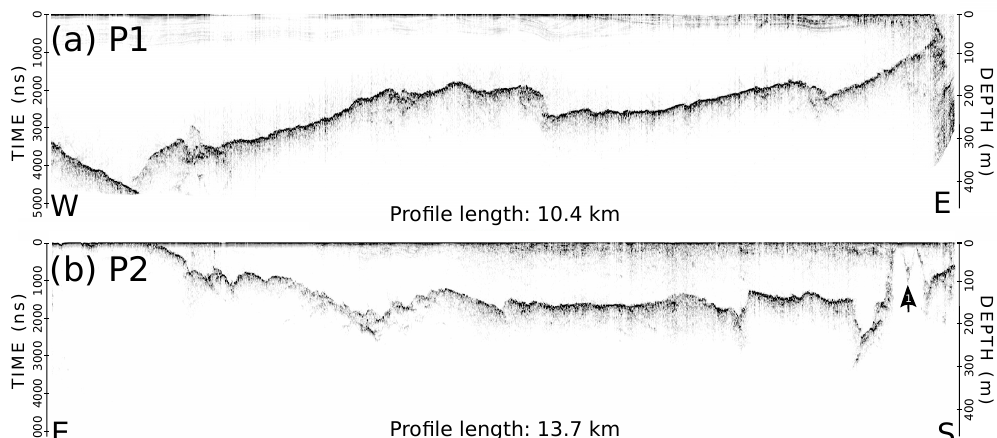
Figure 5. ( a , b ) GPR measurements from 2018 for the profiles P1 and P2 in Figure 2a. The arrow 1 marks bedrock structures assumed to be a